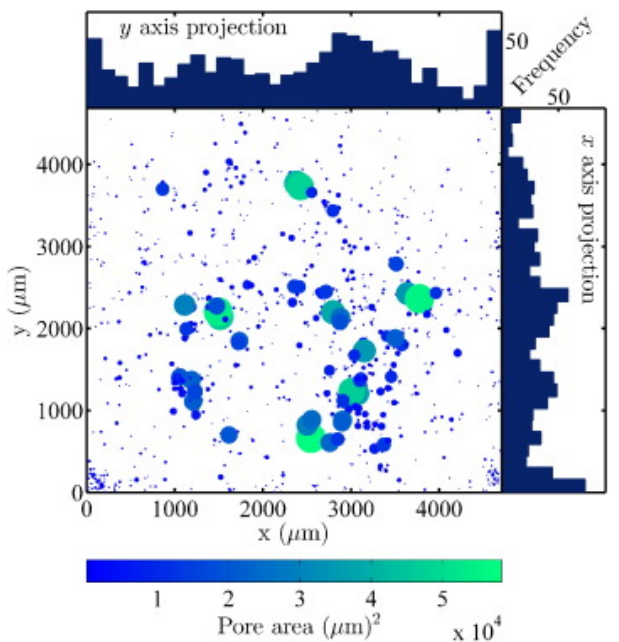
Figure 32. Pores in an AlSi10Mg SLM sample characterized by X-ray tomography [162]. Copyright 2015. Adapted with permission from Elsevier Science Ltd. under the license number 4803730656907 (Figure 7 [162]), 7 April 2020.